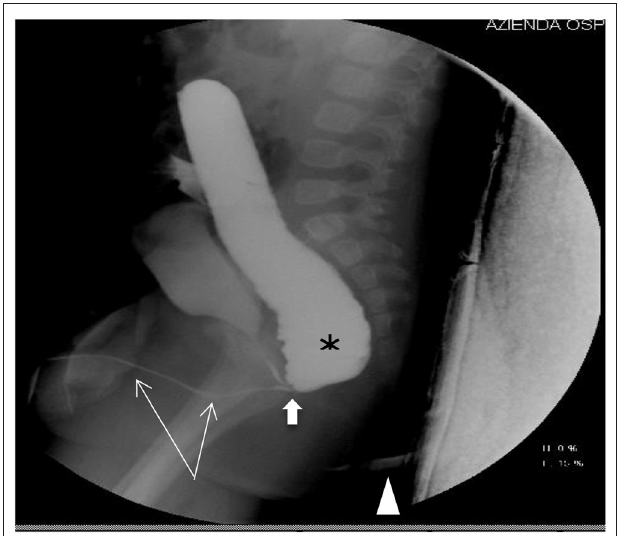
FIGURE 1 | Recto-bulbar fistula: the distal colon is filled with contrast (asterisk), the entire urethra is visible (thin arrows), the recto-bulbar fistula is clearly recognizable (fat arrow), and the anal dimple is marked